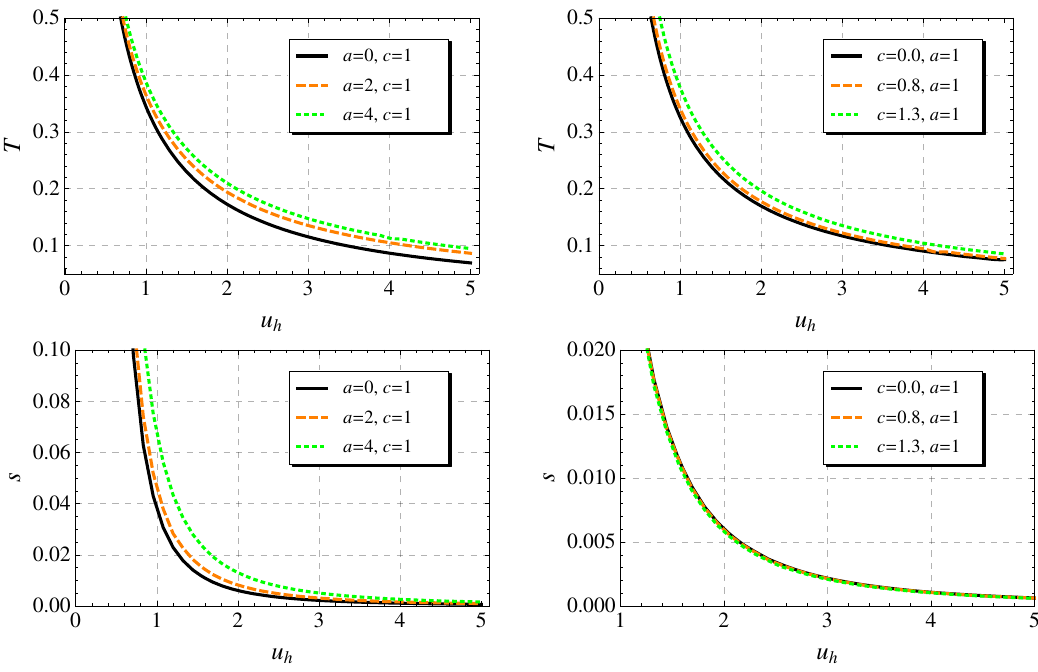
Figure 4 . Visualization of the temperature T and the entropy density s as a function of u h for di(cid:11)erent values of the parameters a and c . The shapes of the curves always look alike, but the temperature and the entropy density increase for growing a . For growing c only the temperature shows a signi(cid:12)cant change. As expected from counting the scales of the theory, the numerics show that the maps u h T and u h s are one-to-one and onto for all values of the 7! 7!